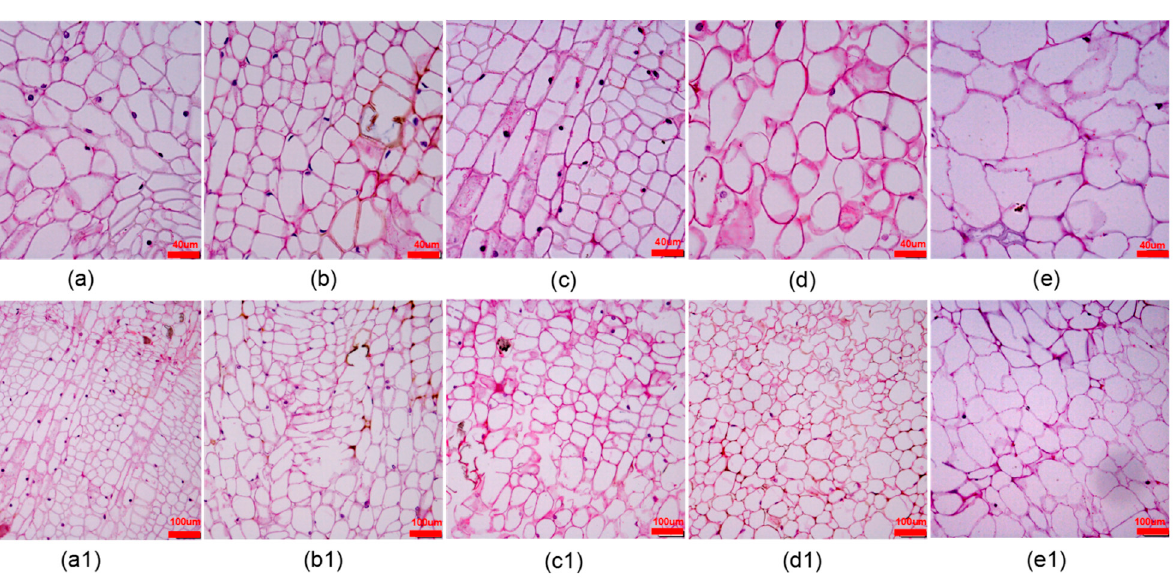
Table 7. Effects of different hormone combinations on the subculture and proliferation of D. lotus.